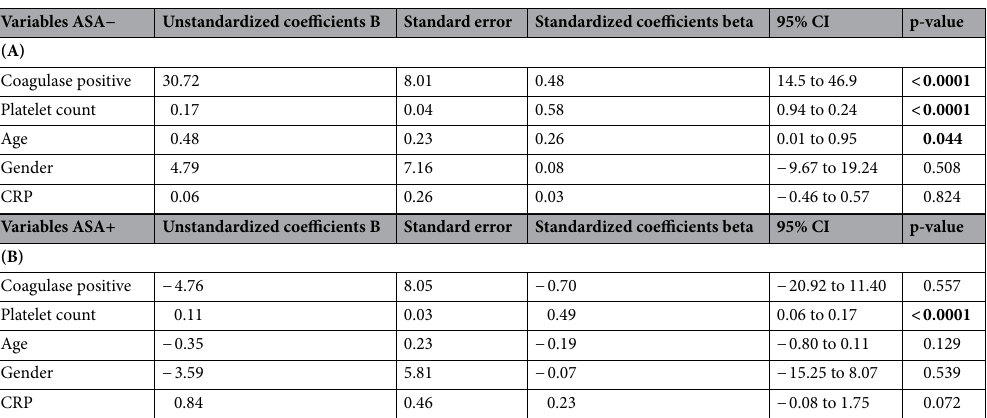
Table 1. Multivariate linear regression of results on ADP induced platelet aggregation in patients with coagulase negative and SA coagulase positive IE without and with antiplatelet medication. (A) In patients without antiplatelet medication SA+ IE patients showed increased ADP induced platelet aggregation. This finding was robust after adjustments for age, gender, CRP and platelet count in multivariate analysis. (B) In patients with antiplatelet medication ADP induced platelet aggregation showed no differences. In a linear regression model, only platelet count was significantly associated with ADP induced platelet aggregation measured by Multiplate ® . Significant values are in